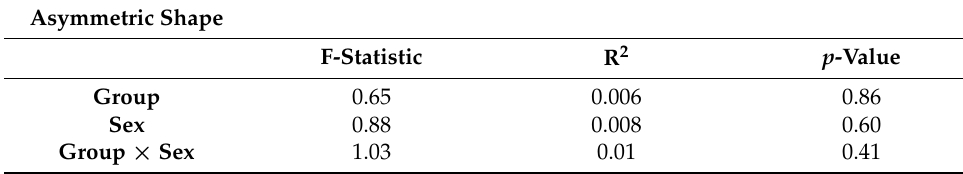
Figure 6. Distribution of PC scores along the first two asymmetric PC axes. The percentages indicate the proportion of individuals below and above zero (perfect symmetry) for captive (brown) and wild (green) individuals. Table 4. Results of the Multivariate Procrustes ANOVA between the dependent variable of asymmet- ric shape and the independent variables of “group” (wild and captive) and “sex” and their interaction. Asterisks indicate significance: * p -value ≤ 0.05; ** p -value ≤ 0.01; *** p -value ≤ 0.001.